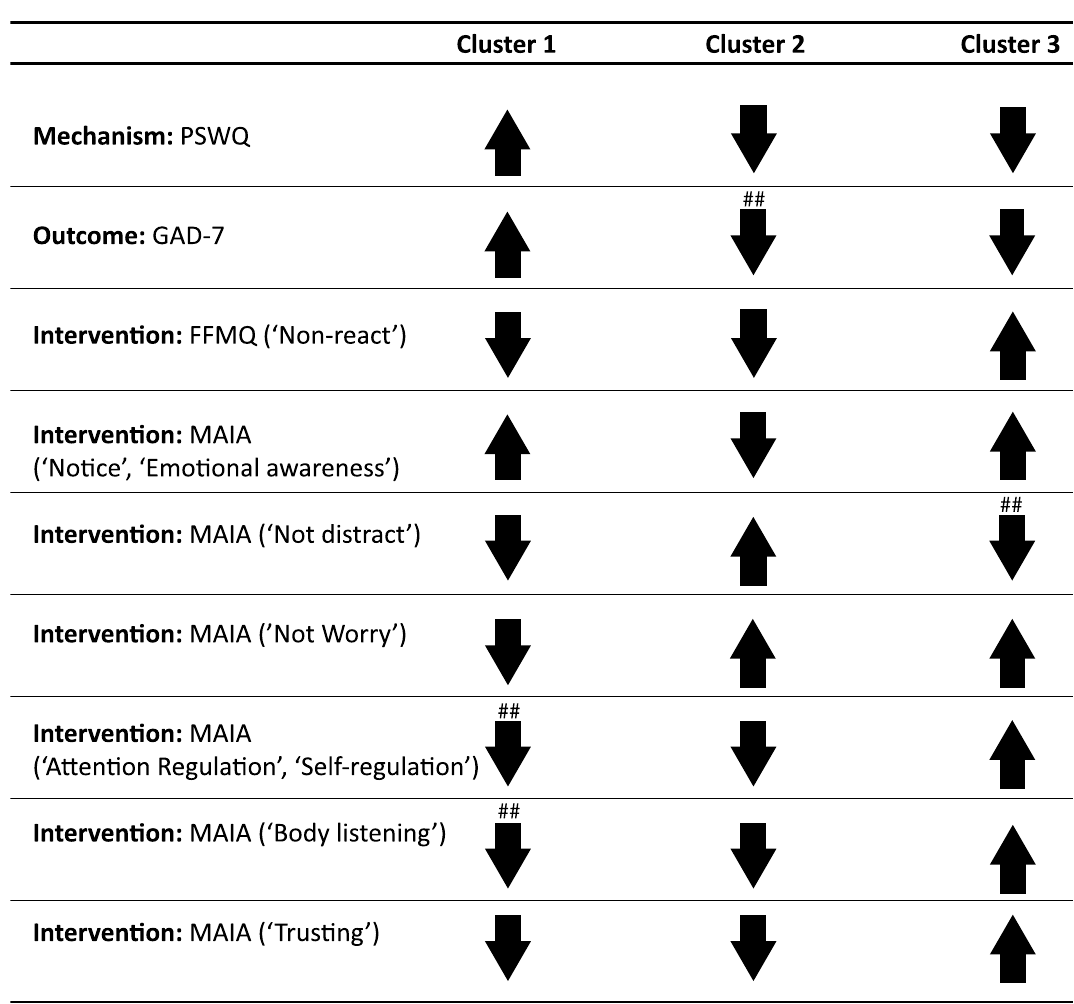
Within-cluster average z-scores indicated a 98.4% similarity with cluster 3 from Study 1 (correlation r = 0.92 between the studies’ within-cluster average z-scores).